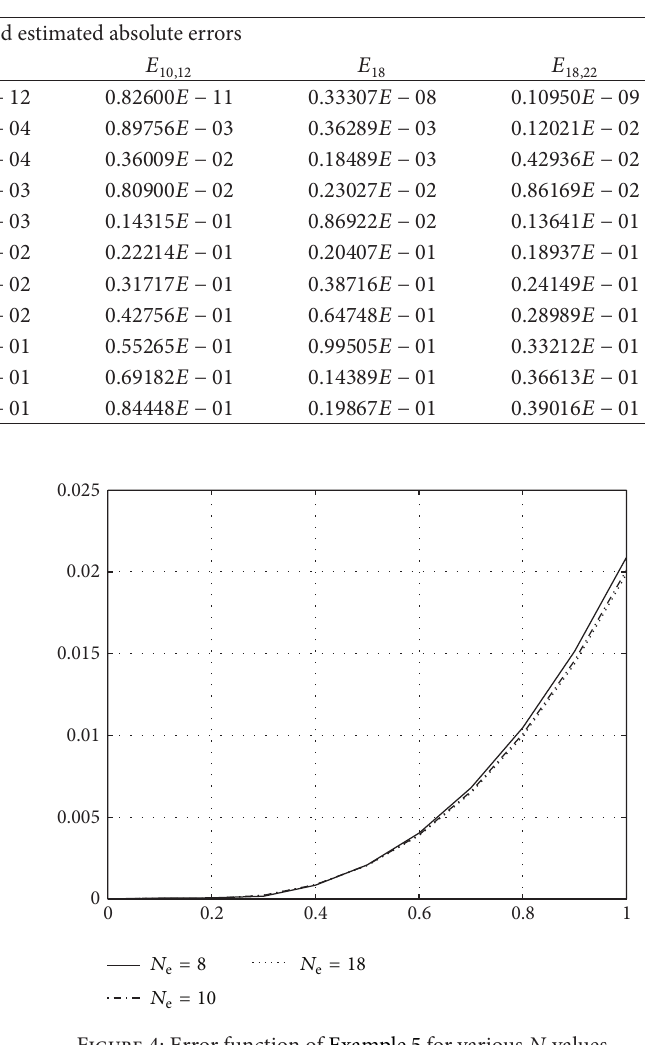
Figure 4: Error function of Example 5 for various 𝑁